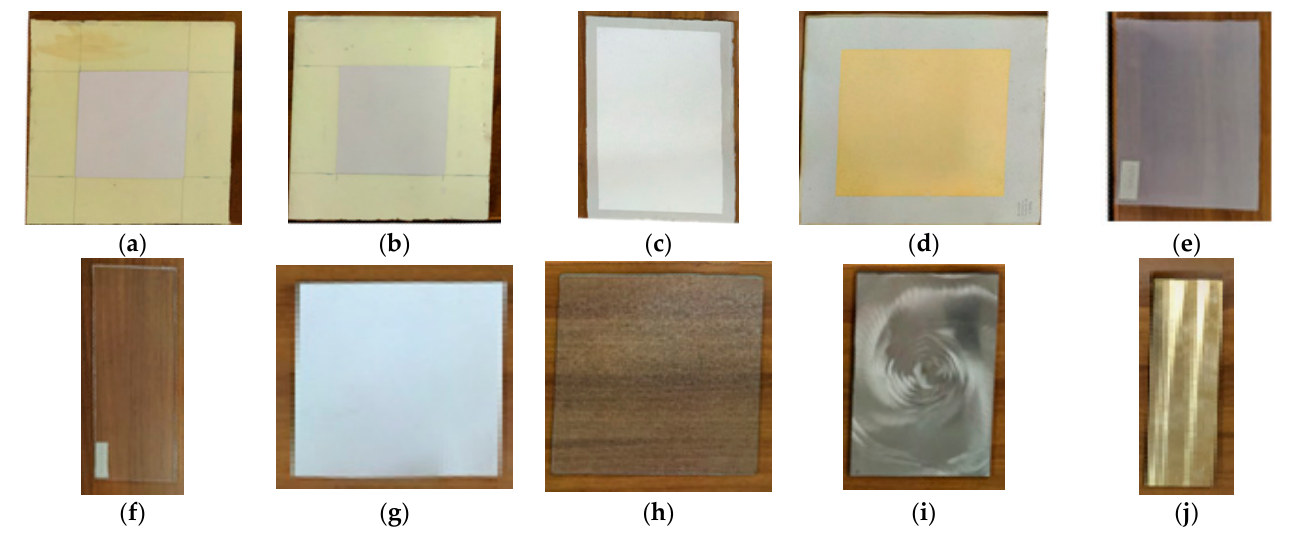
Figure 2. Set of scanned samples in the first test: smooth cement plaster ( a ), raw cement plaster ( b ), white lime plaster ( c ), coloured lime plaster ( d ), tetrafluoroethylene (TFE) ( e ), methacrylate (PMMA) ( f ), high-density polyethylene (HDPE) ( g ), frosted glass ( h ), steel ( i ), brass ( j ).